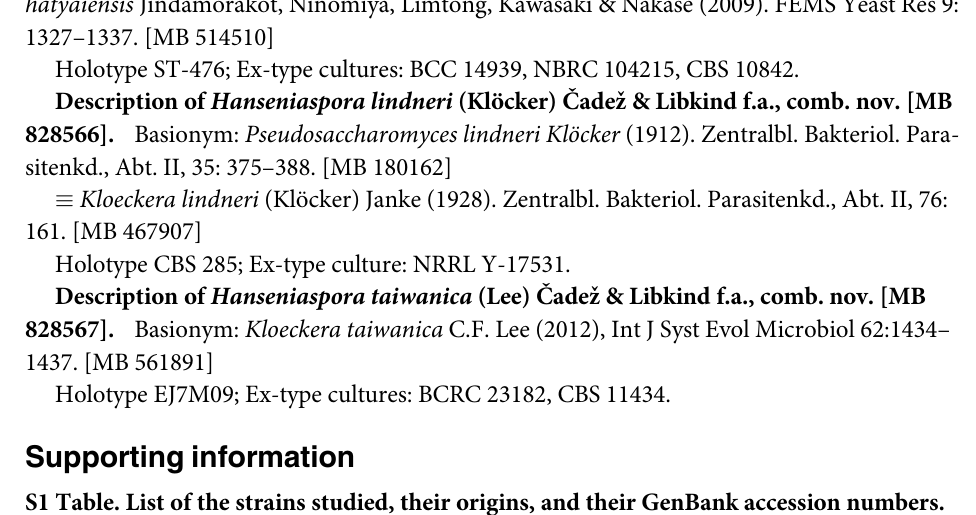
S2 Table. Similarities among closely related genomes. The values are presented as the Align- ment-Free Distance Measure (Kr), Average Nucleotide Identity (ANI) and by estimating digi- tal DNA-DNA Homology values (dDDH values) in comparison to DNA-DNA reassociation [36,62] where available. S1 Fig. UPGMA dendrogram based on PCR fingerprints obtained with the microsatellite primers (GTG)5x and (ATG)5x on Hanseniaspora gamundiae sp. nov. and their closest rel- atives. The distances between the strains were computed using Pearson’s correlation coeffi-